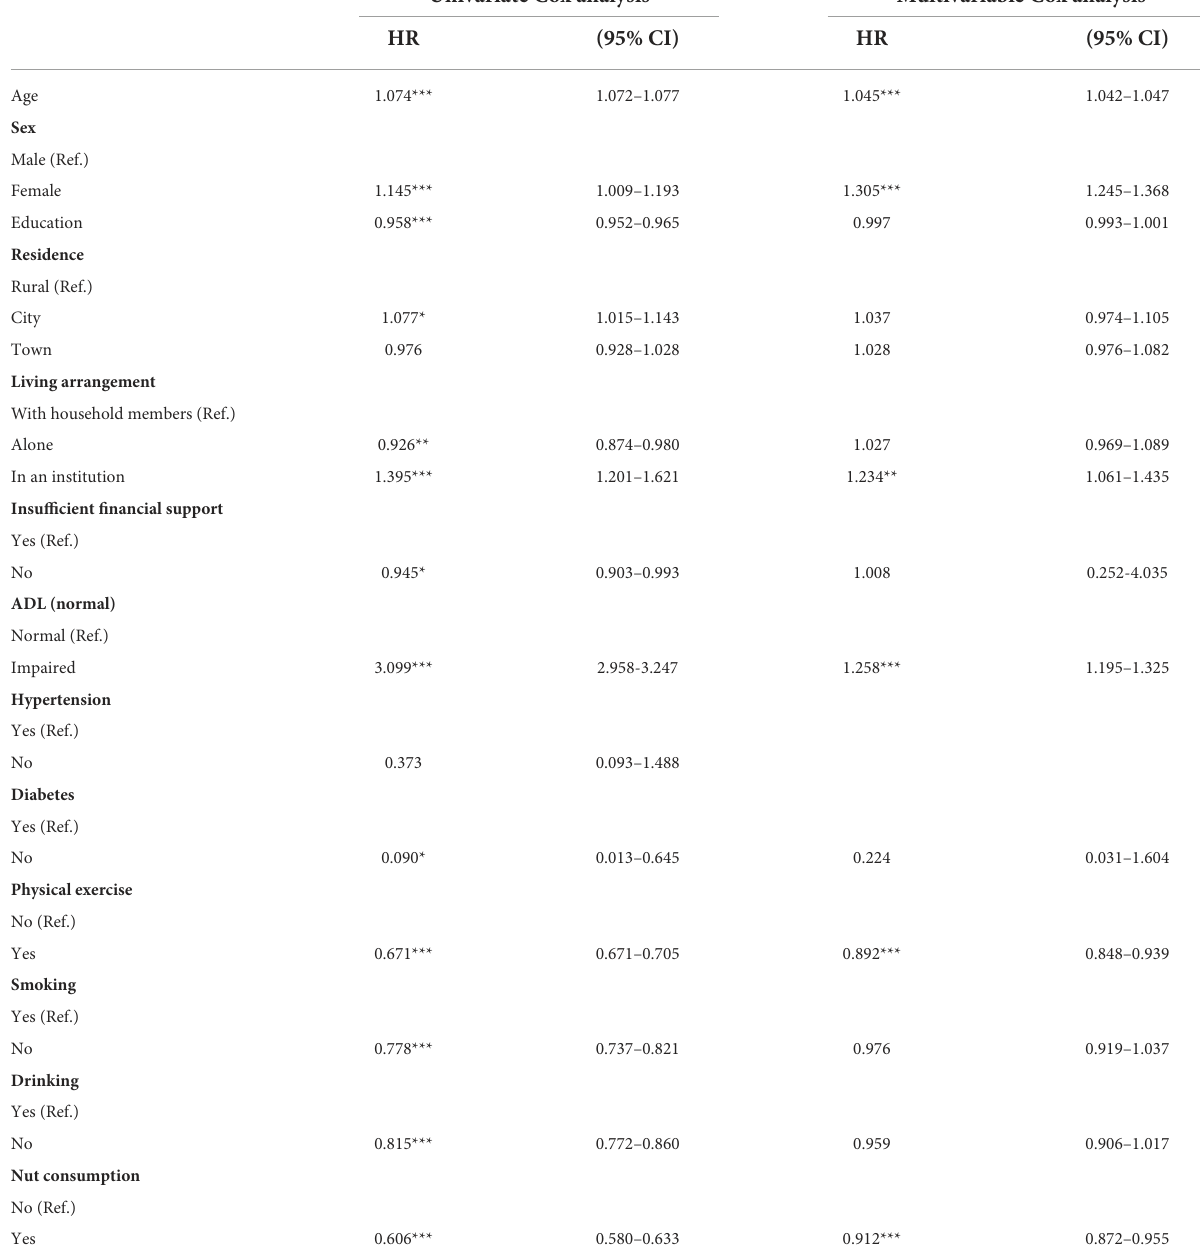
TABLE 2 The Cox analysis of all variables. Univariate Cox analysis Multivariable Cox